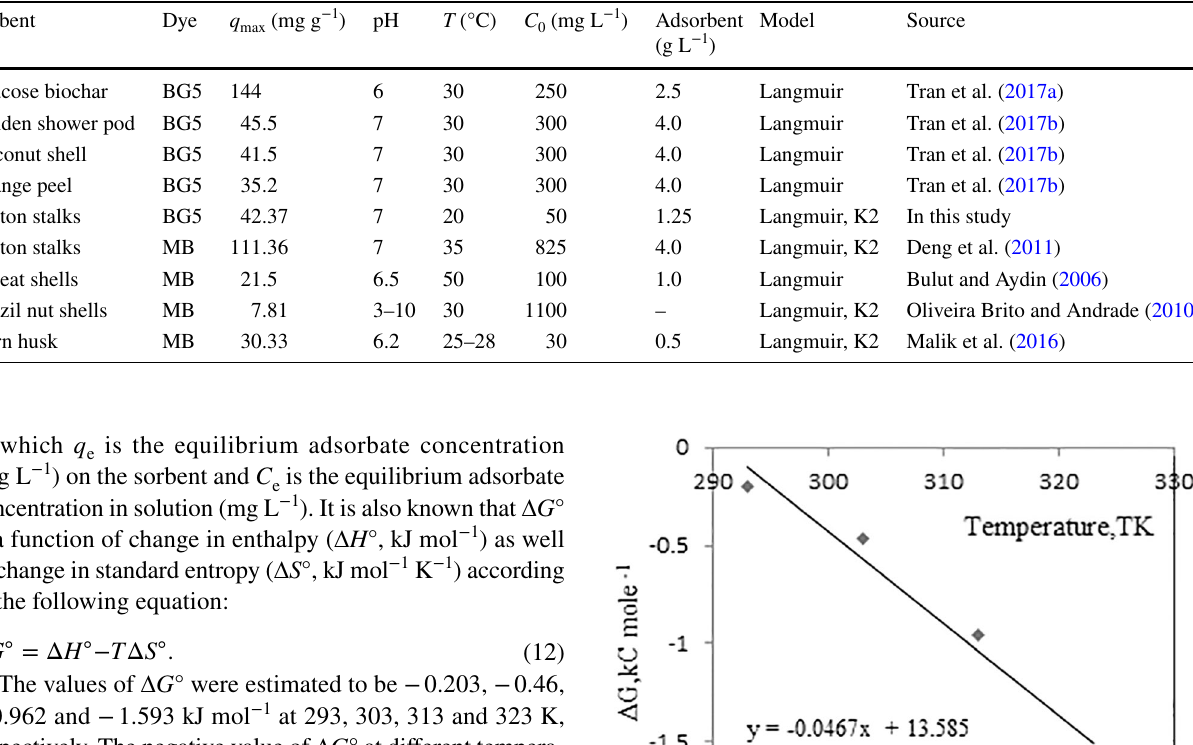
Table 5 Comparison of BG 5 dye uptake data with other adsorbents on the basis of an agricultural wastage